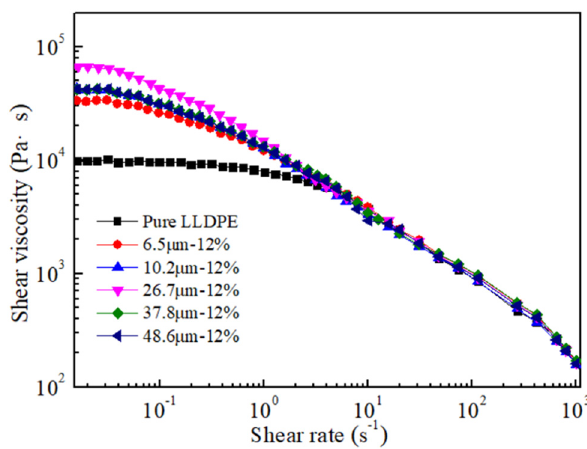
Figure 4: Shear viscosity versus shear rate of the Al 2 O 3 /LLDPE composites with di ff erent Al 2 O 3